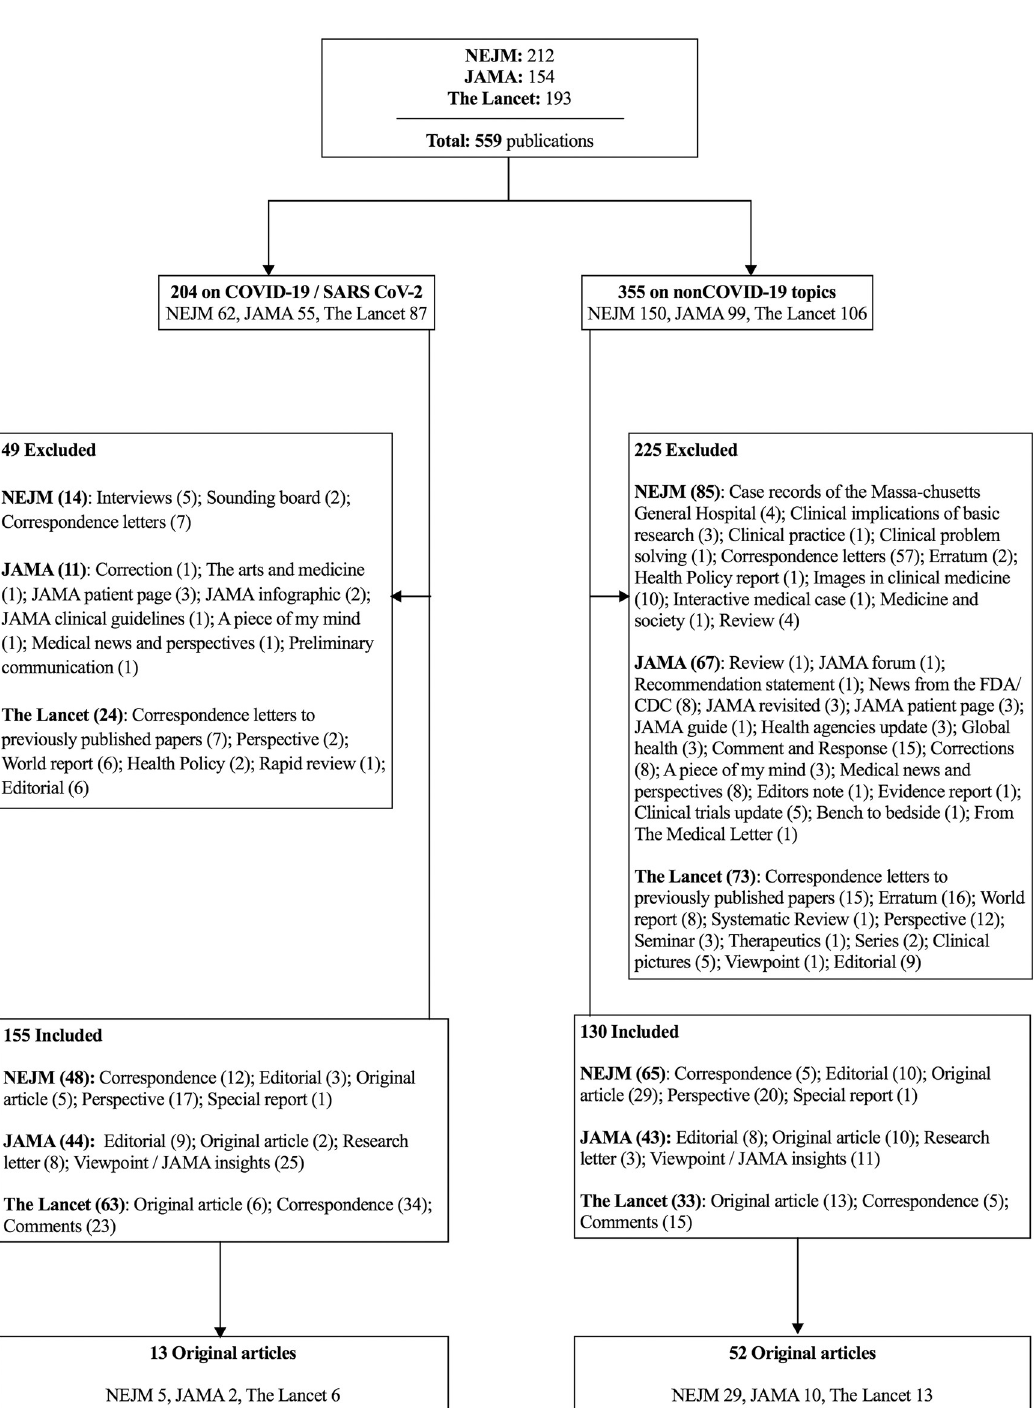
Fig 1. Flow chart of the processing of the publications included in this study. The article types in the NEJM are grouped (by the publisher) into Original Research (Research Articles and Special Articles for research on economics, ethics, law and health care systems), Clinical Cases (Brief Reports and Clinical Problem Solving), Review Articles (Clinical Practice Review or Other Reviews), Commentaries (Editorials, Perspectives, Clinical Implications of Basic Research, Letters to the Editor, Images and Videos in Clinical Medicine), and other articles (Special Reports, Policy Reports, Sounding Board, Medicine and Society and Case Records of the Massachusetts General Hospital). The JAMA articles are grouped by the publisher into Research (Original Investigation, Clinical Trials, Caring for the Critically Ill Patient, Meta-Analysis, Brief Reports and Research letters), Clinical Review and Education (Systematic Reviews, Advances in Diagnosis and Treatment, Narrative Reviews, Special Communications, Clinical